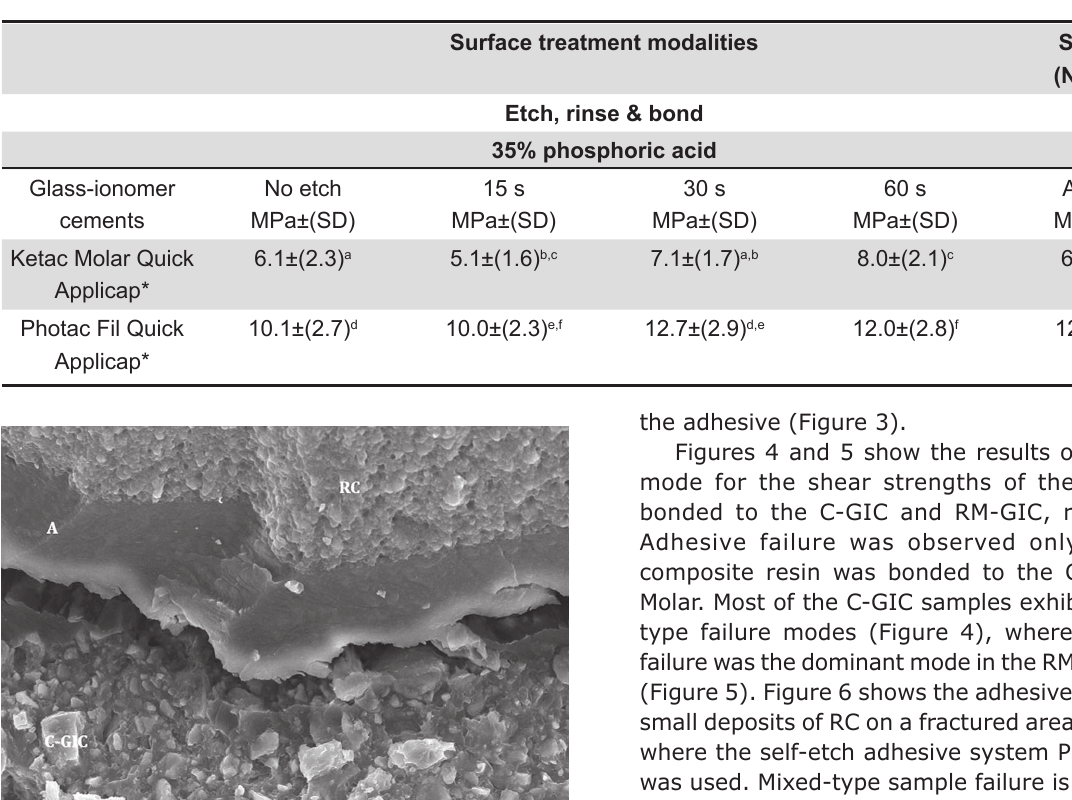
Table 1- Mean bond strength (MPa) of resin composite to two different types of glass-ionomer cements treated with various surface treatment procedures of different adhesive systems. Same symbol and letters within a group indicate statistically significant differences